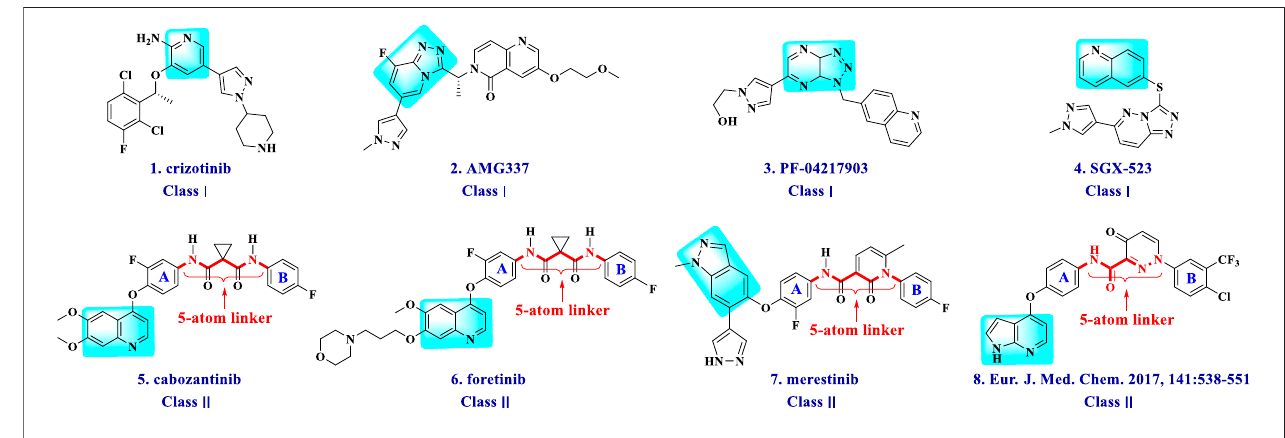
FIGURE 1 | Structures of small-molecule mesenchymal – epithelial transition factor (c-Met) inhibitors.